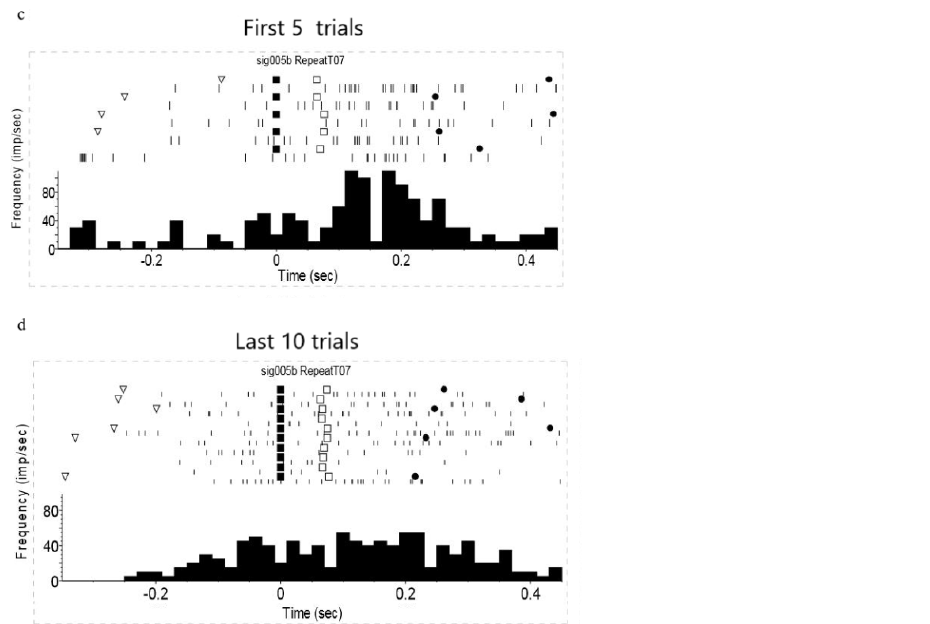
Figure 7. Perievent rasters for single unit in different perturbation conditions. ( a ) Perievent rasters for single unit during the unperturbed trials. Time zero was aligned to movement onset. The triangles represent target light on, and the diamonds represent target hit. ( b ) Perievent raster plot for the single unit during the unperturbed and perturbation trials. The top plot shows the random CW perturbation trials; the bottom shows the repeated CW perturbation trials. Time zero was aligned to movement onset. Perturbation occurred at 70 ms after center release (squares). The triangles represent target light on, and the diamonds represent target hit. ( c ) Perievent raster plot for the single unit during the first five repeated perturbation (bottom) trials. Time zero was aligned to movement onset. Perturbation occurred at 70 ms after center release (squares). The triangles represent target light on, and the diamonds represent target hit. ( d ) Perievent raster plot for the single unit during the last ten repeated perturbation (bottom) trials. Time zero was aligned to movement onset. Perturbation occurred at 70 ms after center release (squares). The triangles represent target light on, and the diamonds represent target hit. All data originate from the same neuron (sig005b) in different